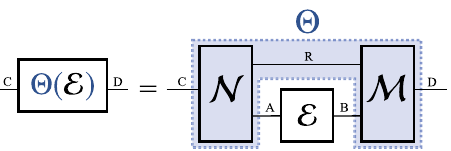
Fig. 1 The general structure of a superchannel. Given the Hilbert spaces of two quantum systems A and B , we write CPTP( A → B ) to denote the set of quantum channels, i.e. completely positive and trace-preserving (CPTP) maps between operators acting on spaces A and B . We associate with each channel E : A ! B its Choi matrix J E : ¼ id (cid:4) E ð Φ þ Þ , where Φ þ ¼ ∑ i ; j ii j i jj h j is the unnormalised maximally entangled state and id is the identity channel. Transformations of quantum channels are then maps from CPTP ( A → B ) to CPTP( C → D ), or ( A → B ) → ( C → D ) in short. Under